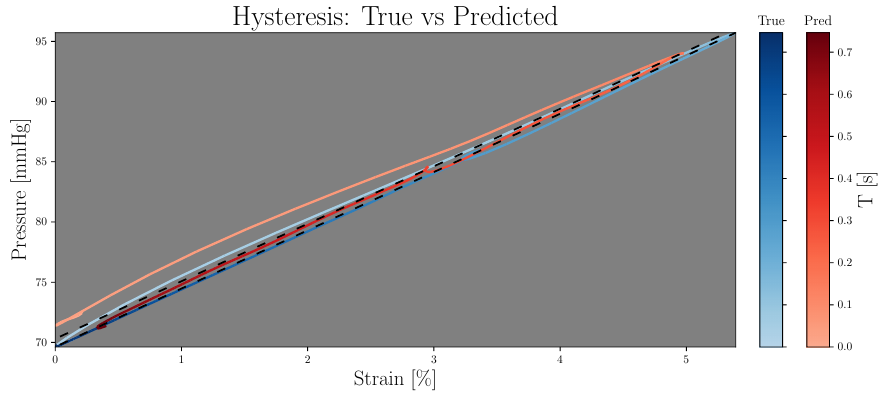
Figure 6. Comparison between true (blue) and predicted (red) hysteresis cycles. Line brightness refers to time; the black dashed lines refer to β and